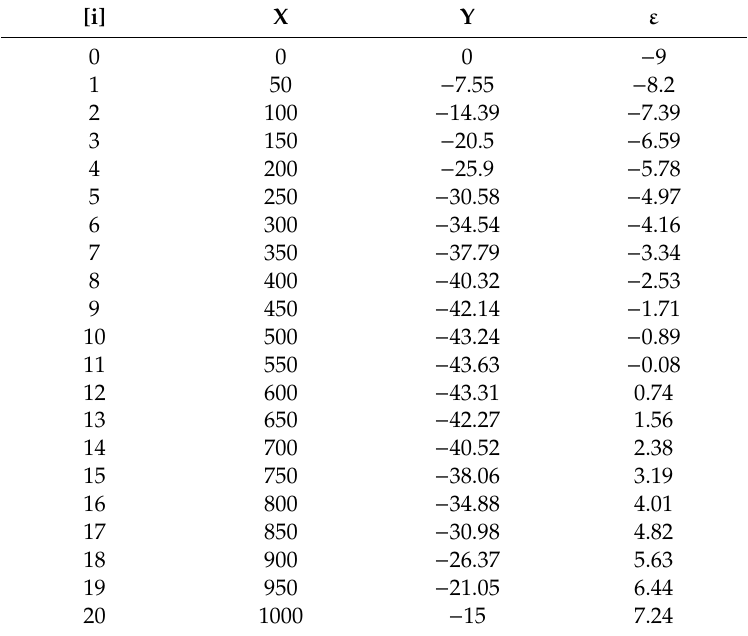
Table 3. Catenary trajectory